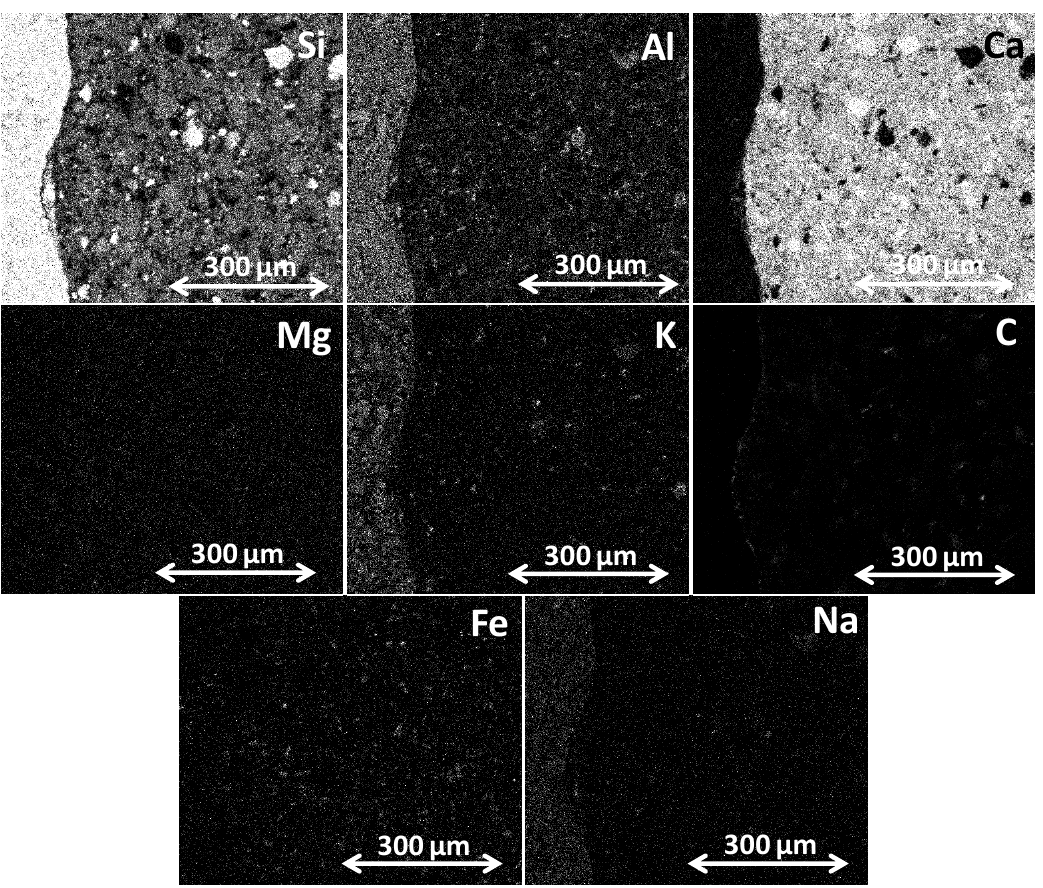
Figure 3. Elemental mapping of the RCA 50 SF sample between the natural coarse aggregate (NCA) and the new paste.